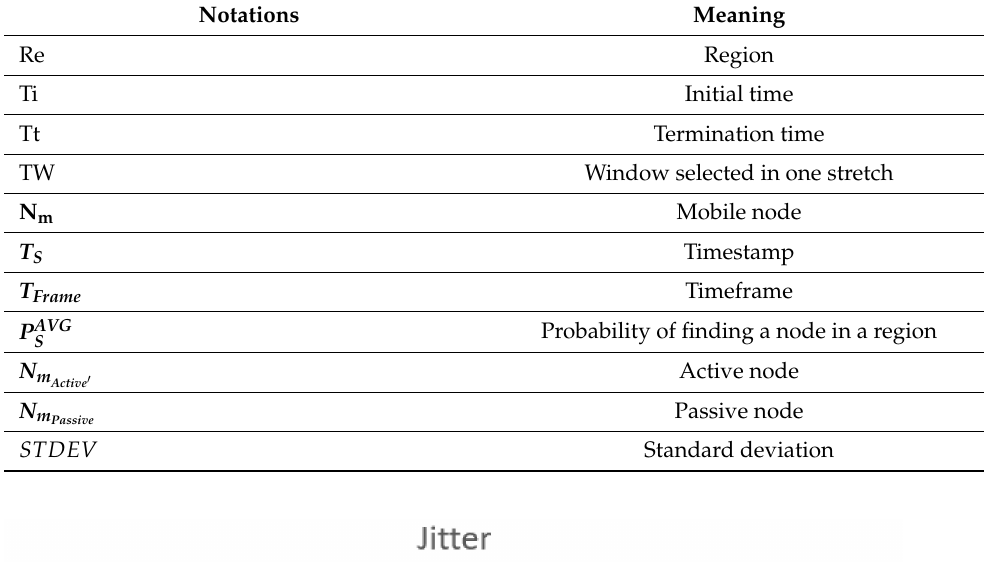
Table 2. Summary of notations.